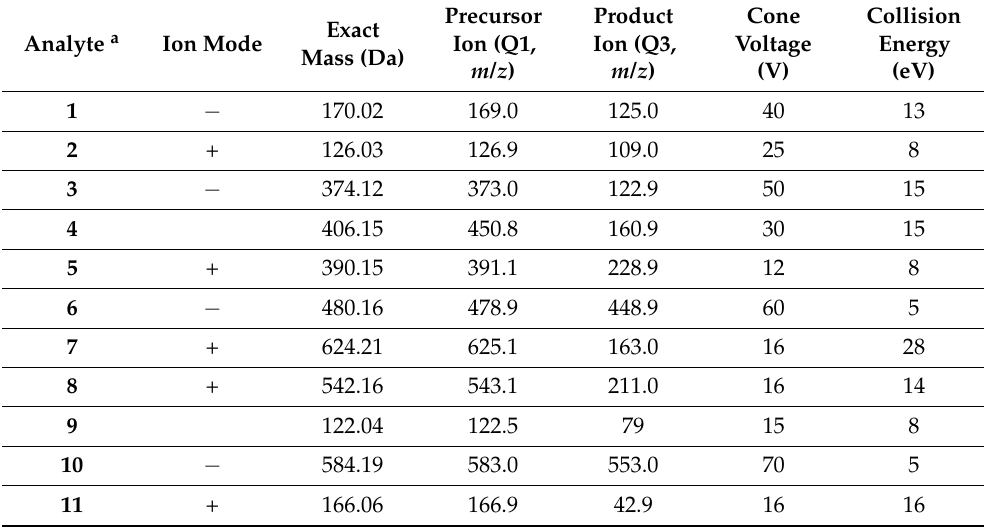
Table 1. MRM parameters of each marker analyte for UPLC–MS/MS